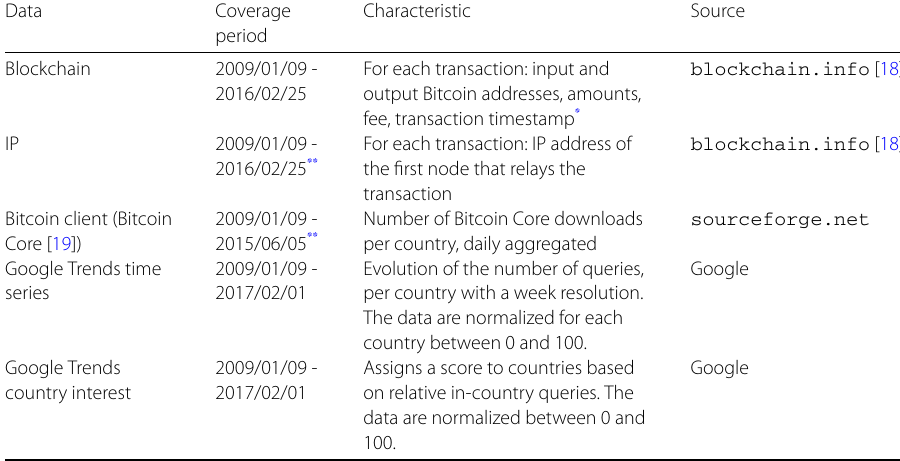
Table 1 Summary of datasets collected from various sources Data